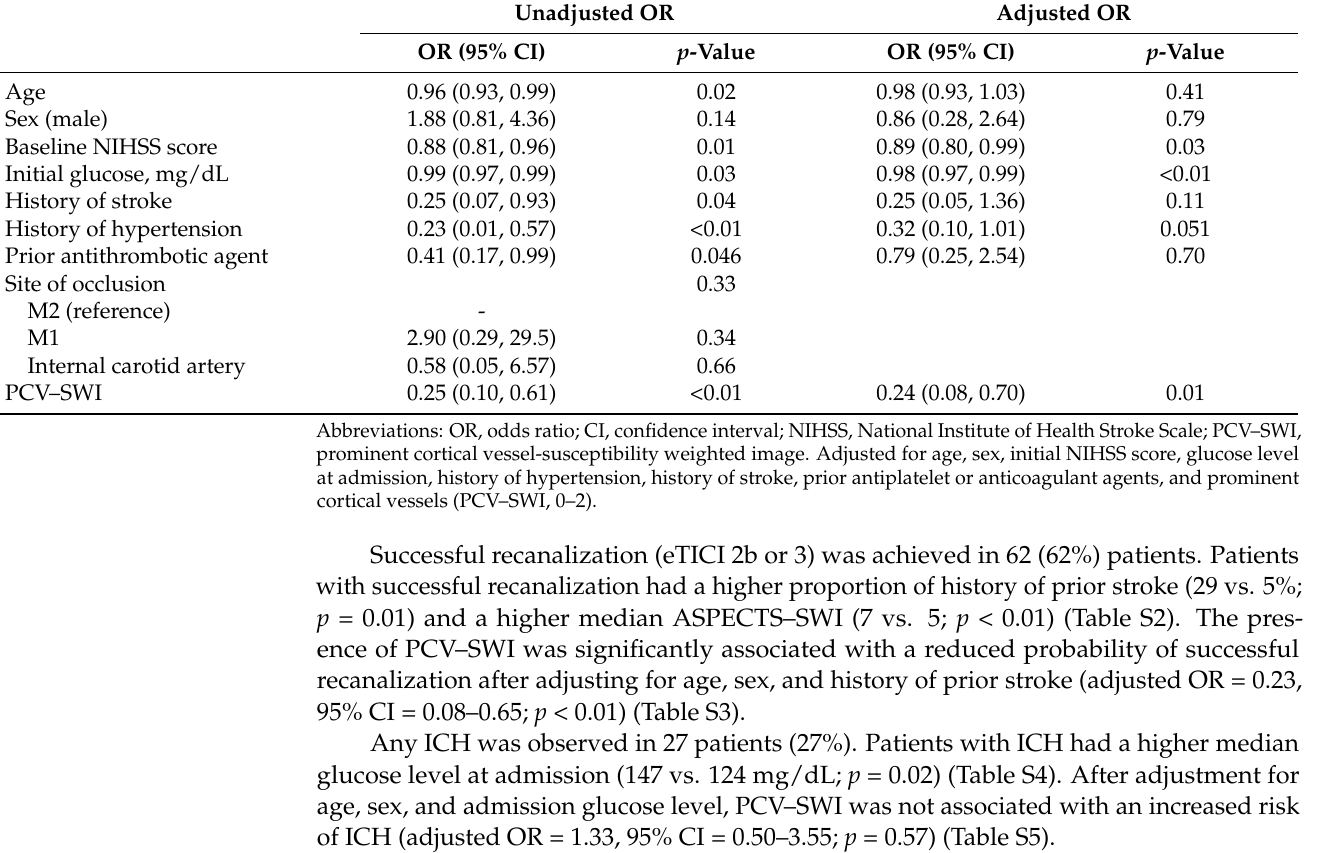
Table 2. Factors associated with good functional outcome at 3 months using logistic regression analyses. Unadjusted